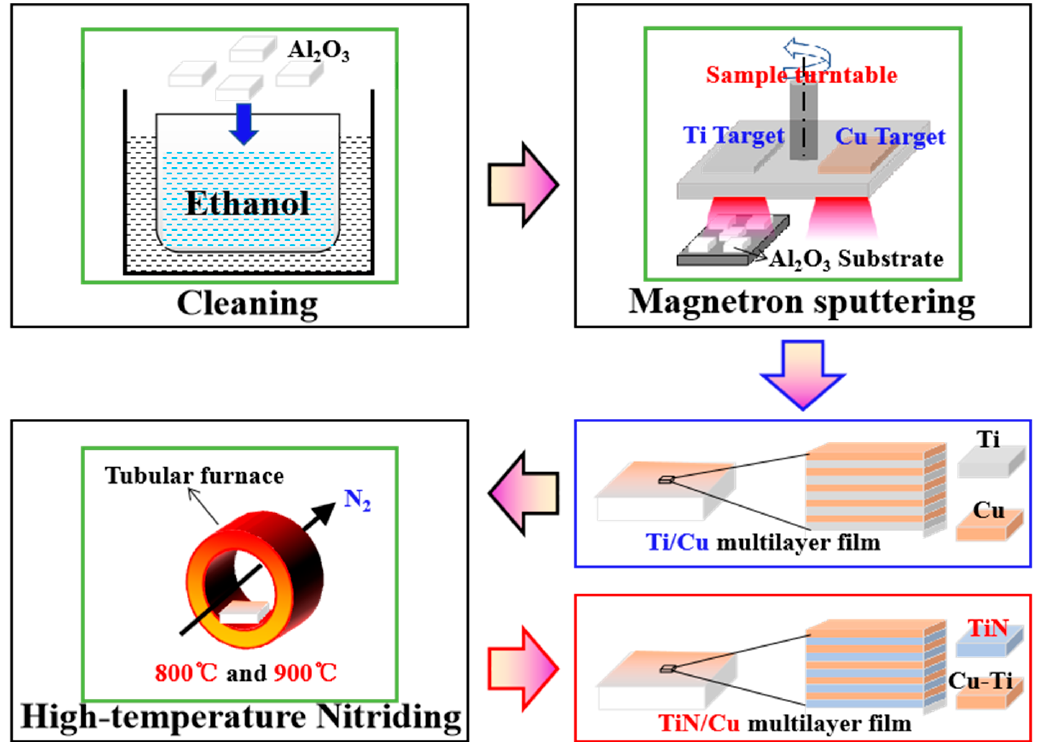
Figure 1. Schematic diagram of the preparation and nitridation process of the Ti/Cu multilayer film.